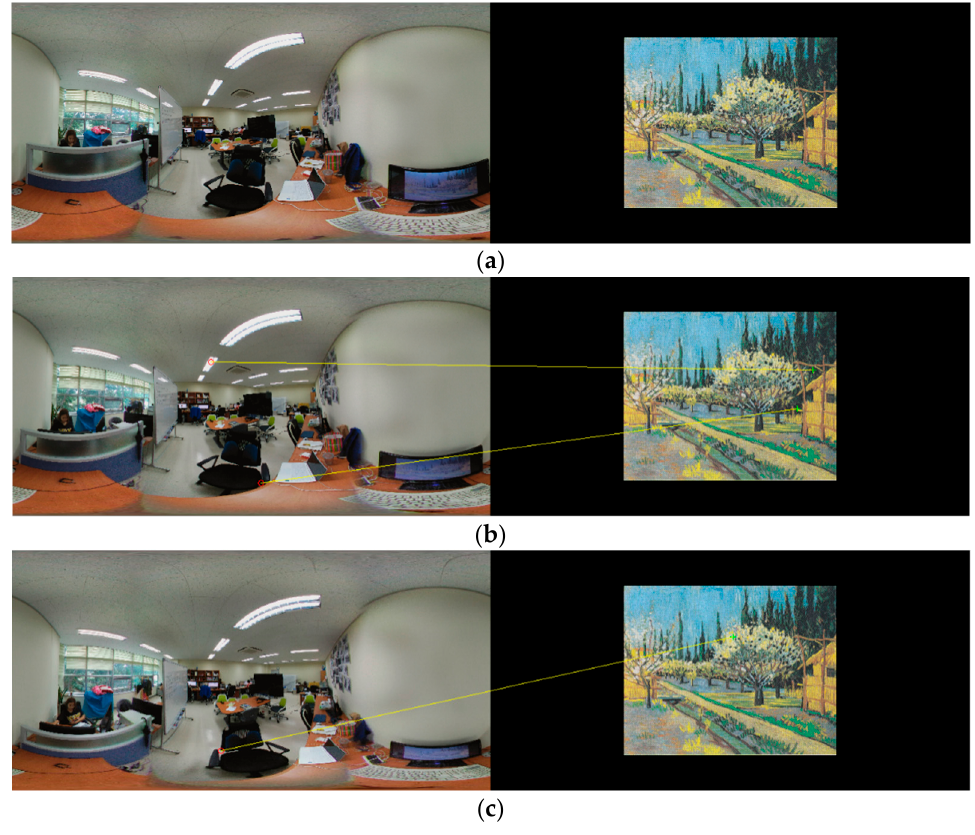
Figure 14. Matched results for the 23-inch monitor for three types of distortions. ( a ) Matched results for low distortion; ( b ) Matched results for middle distortion; ( c ) Matched results for high distortion.